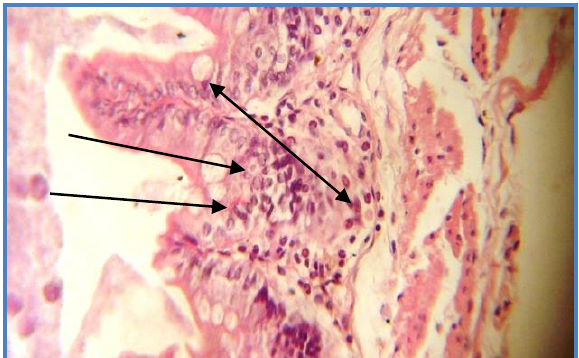
Figure, 11: Intestine of mice at 10 days post infection by Candida albicans and treated with 20% of Datura stramonium extract after 8 days ( ) shows inflammation cells mainly esoinophelis and Neutrophils in the sub epithelial layer with hyperplasia of goblet cells ( ) (Heamatoxcyline and Eosin stain